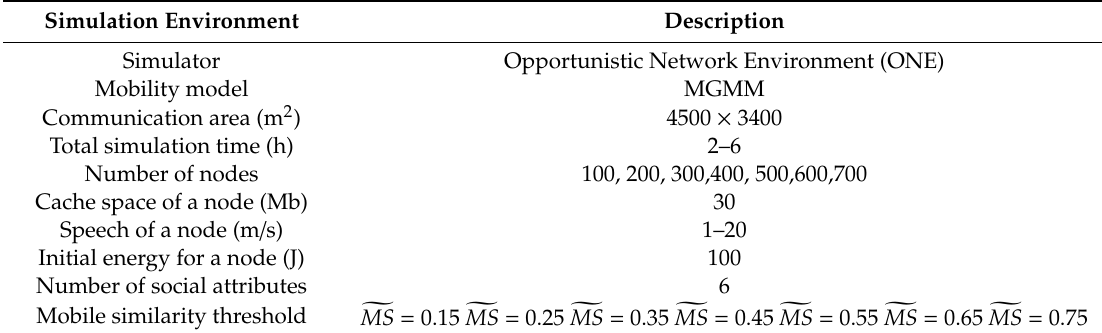
Table 2. The simulation environment for the MSSN routing